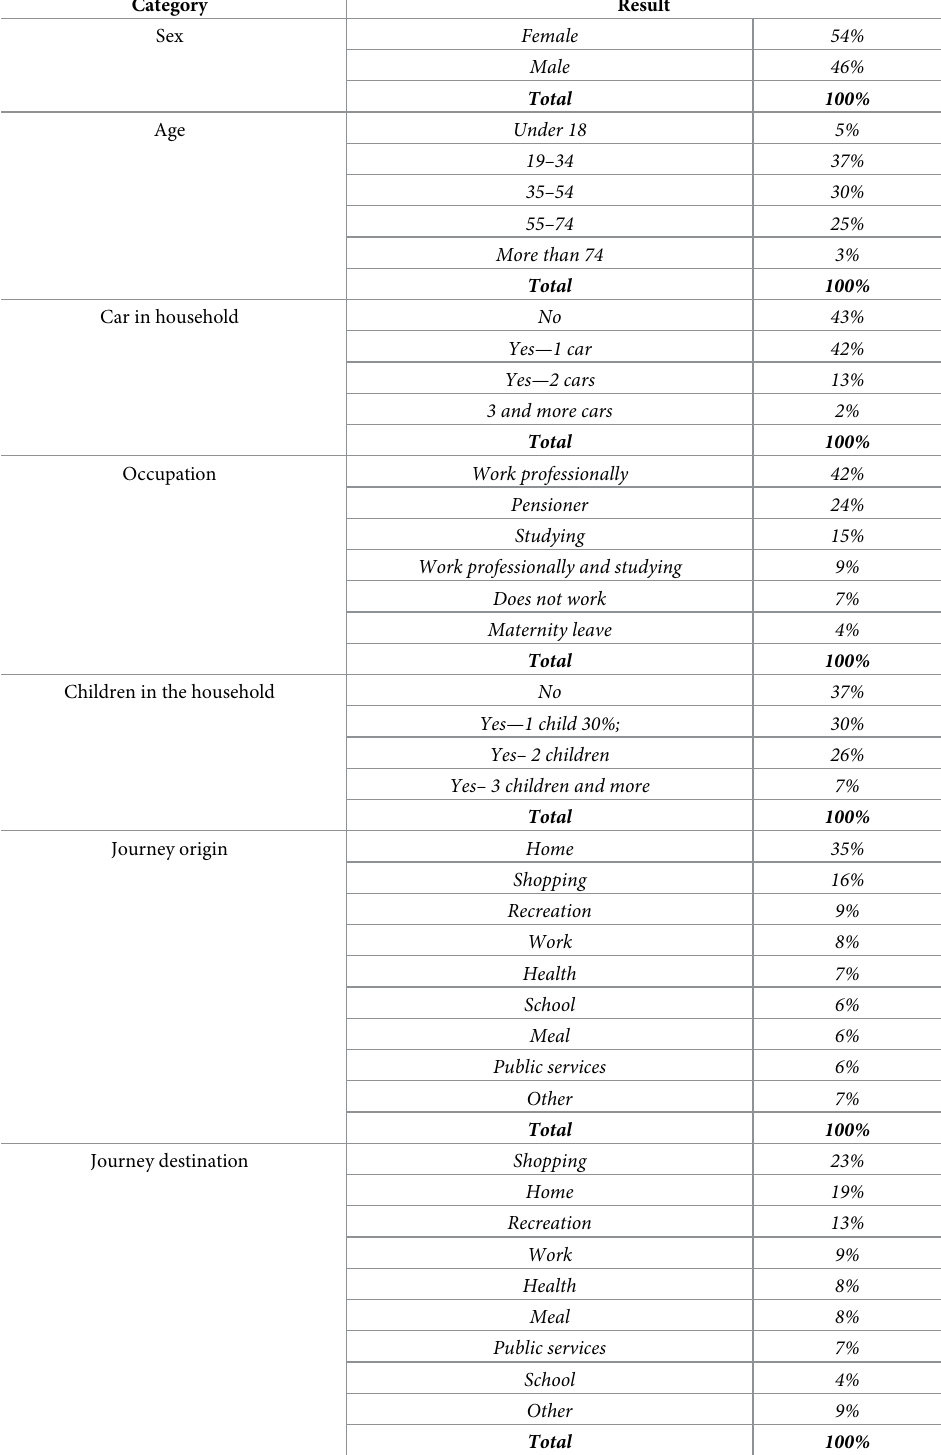
Table 3. Basic characteristics of the